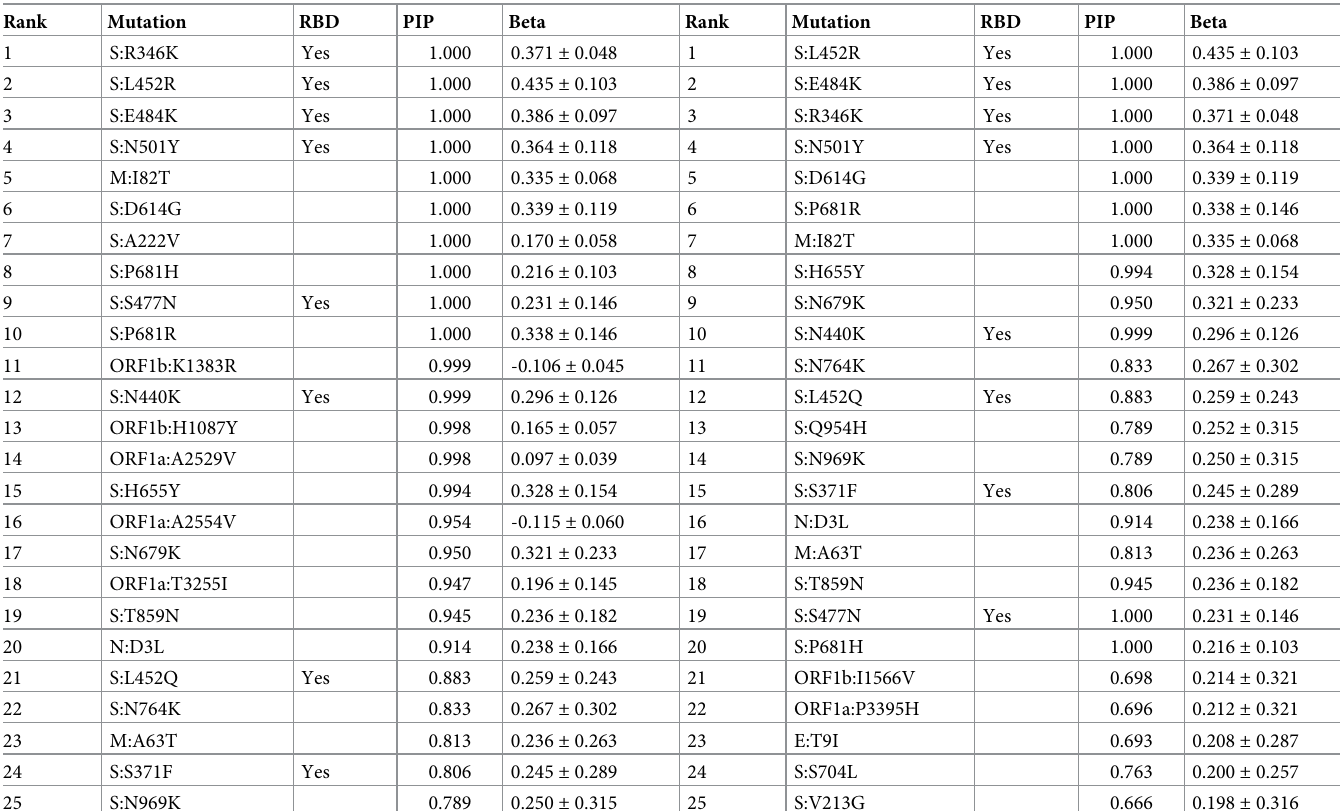
Table 3. Top 25 fitness-associated SARS-CoV-2